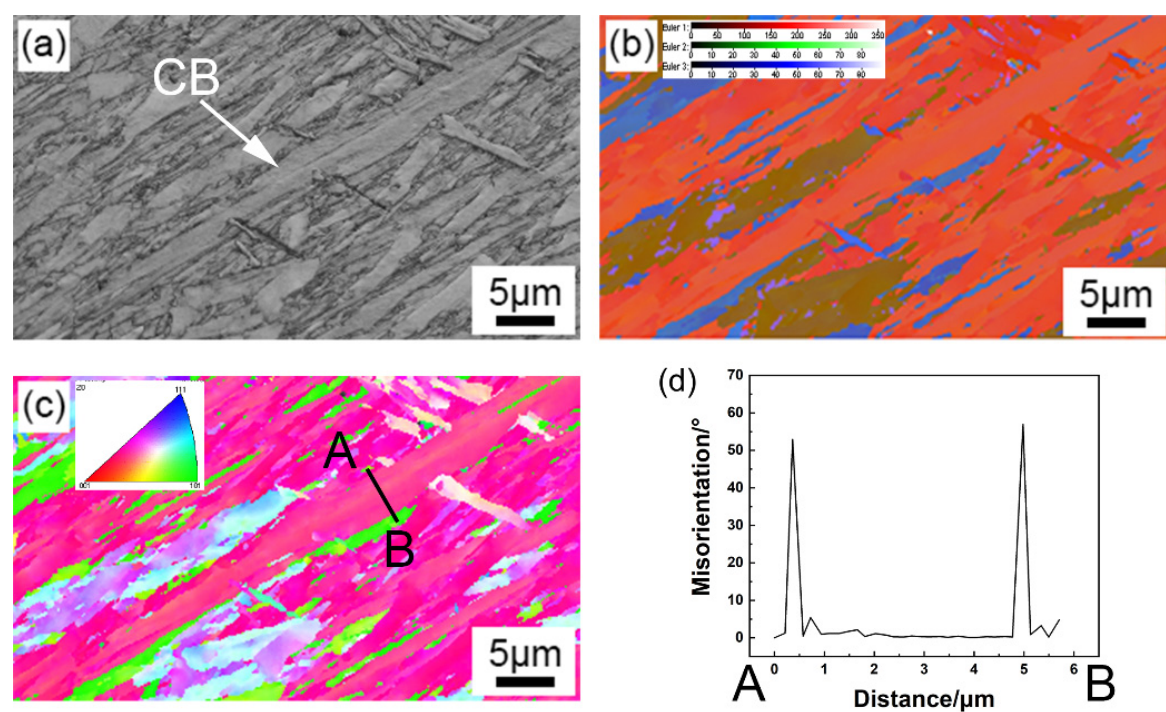
Figure 13. EBSD maps of CB: ( a ) BC map, ( b ) Euler angle color map, ( c ) IPF map, ( d ) the misorientation from matrix to CB.